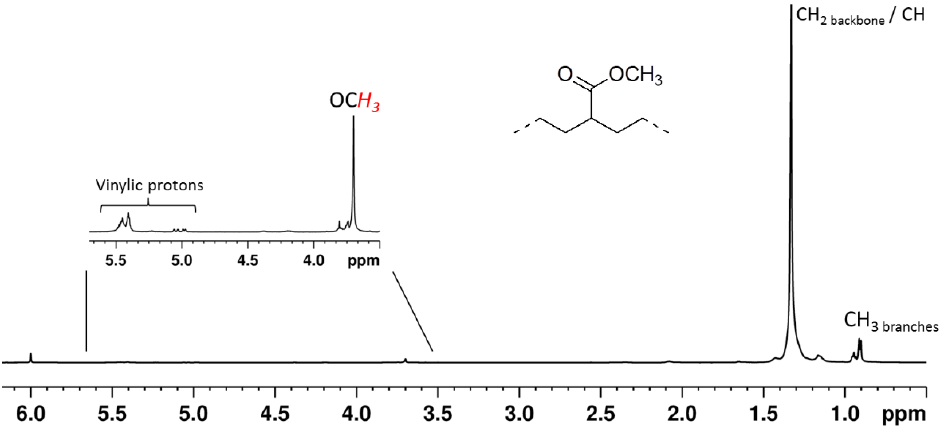
Figure 1. 1 H NMR (C 2 D 2 Cl 4 , 600 MHz, T = 298 K) spectrum of the copolymer sample of run 2, Table 1.